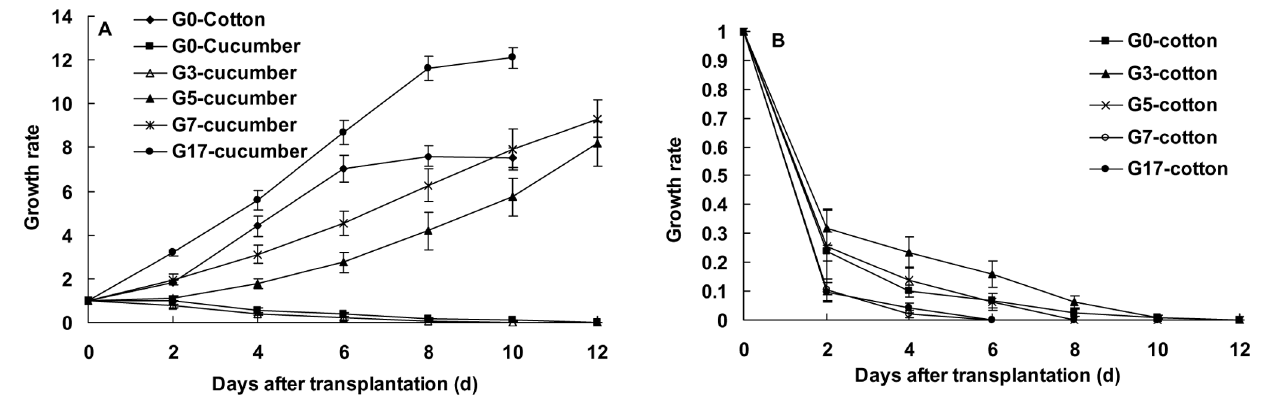
Figure 4. Growth rates of the cotton-specialized aphids on cucumber (A) and the cucurbits-specialized aphids on cotton (B). The transferred aphids were reared for zero, 3, 5, 7, and 17 generations (G0–G17) on zucchini. Bars are means 6 1SE.